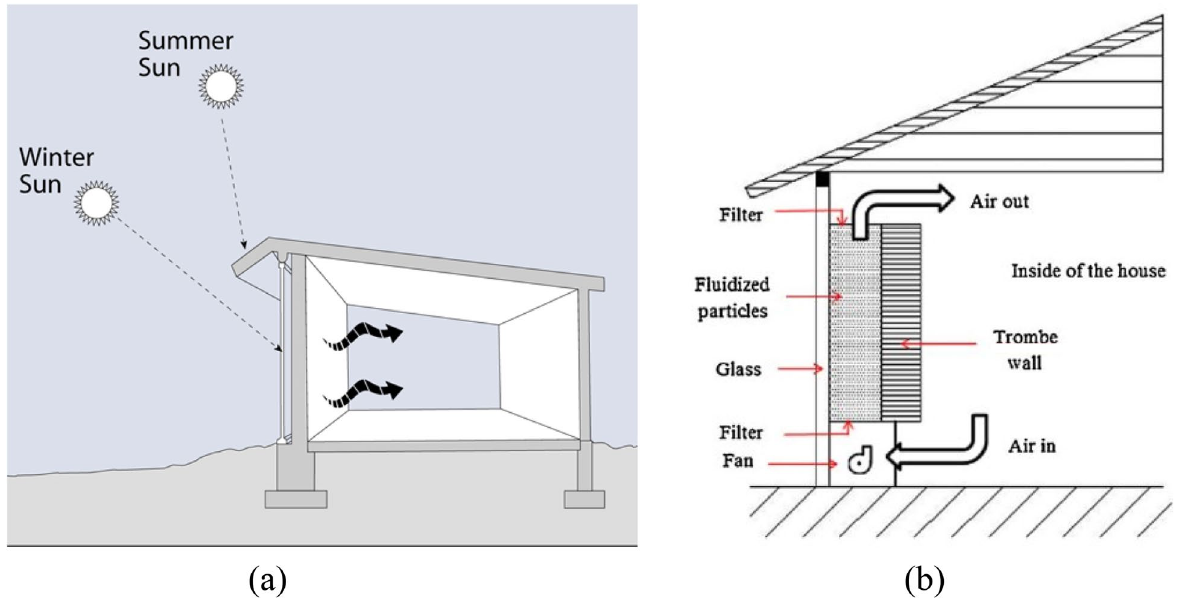
Fig. 3 a A typical passive solar wall (Trombe wall), b Fluidized Trombe wall. Source: Tunc and Uysal